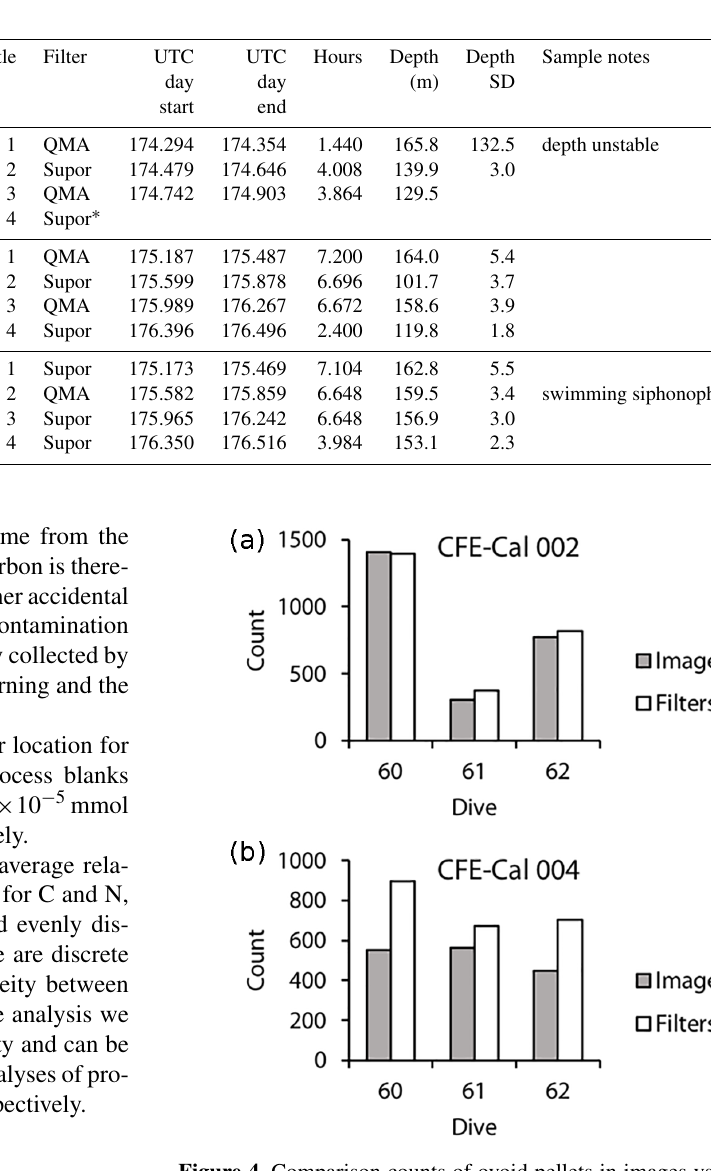
Figure 4. Comparison counts of ovoid pellets in images vs. on fil- ters. (a) CFE-CAL002 deployment 3 (first deployment at location 2), (b) CFE-CAL004 deployment 4 (second deployment at loca- tion